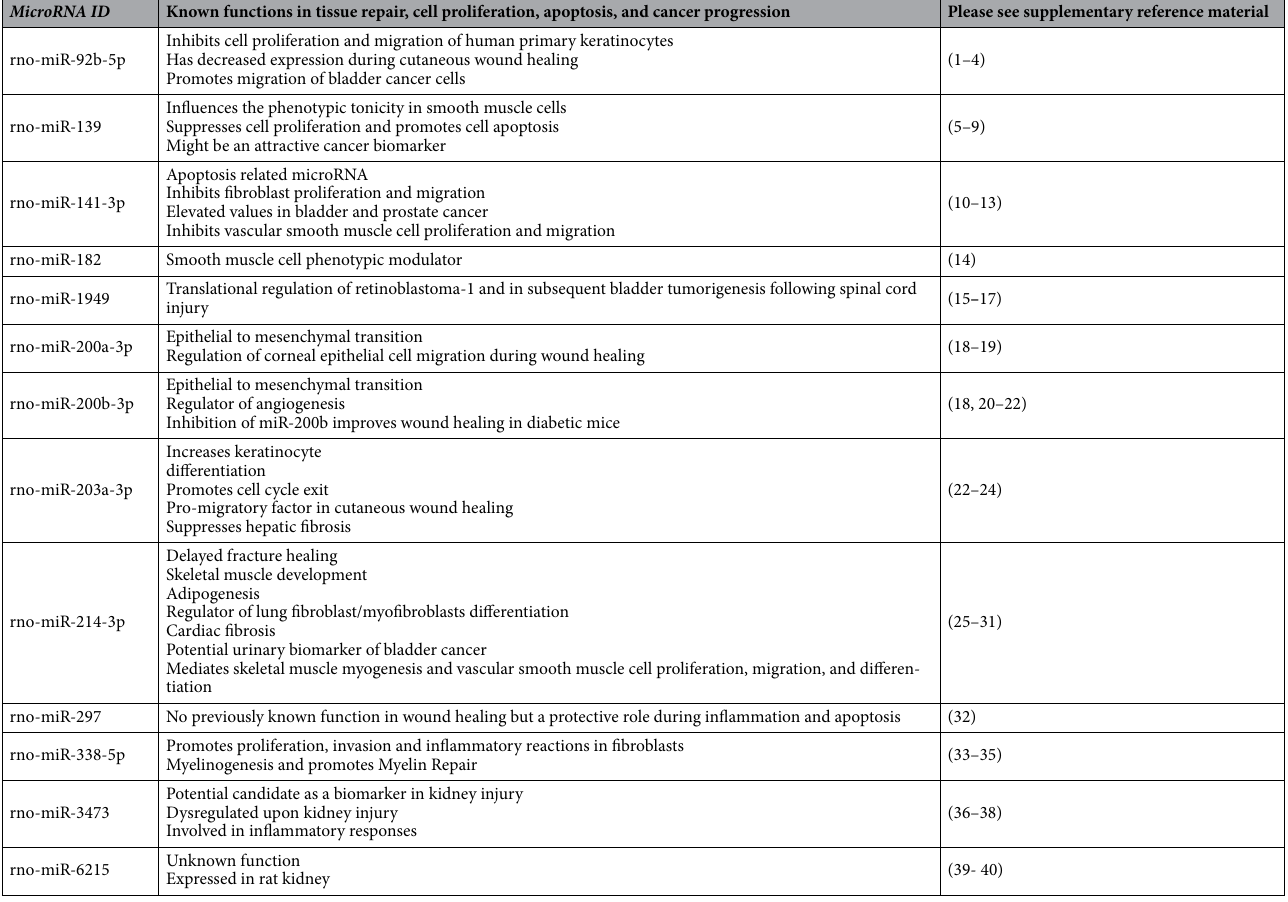
Table 1. Literature review on the known functions of thirteen DE microRNAs in tissue repair, cell proliferation, apoptosis, and cancer progression.